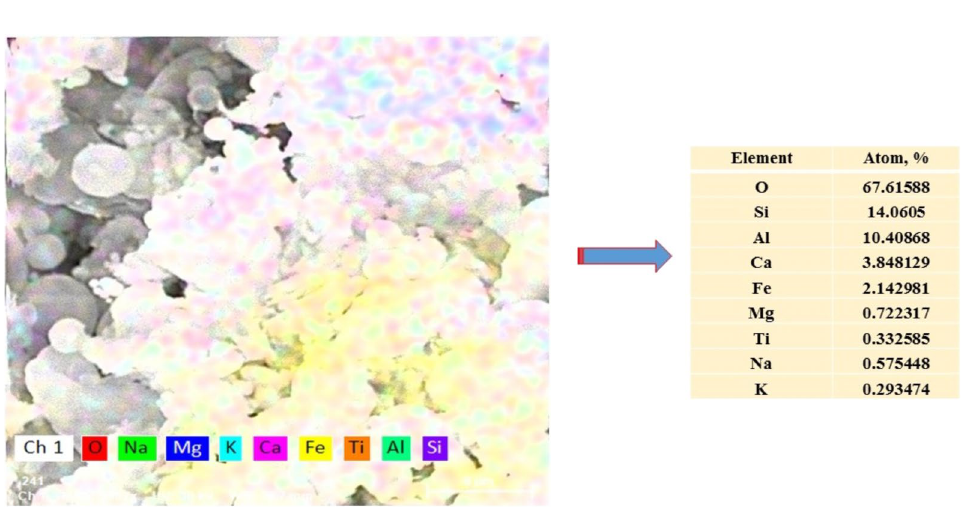
Figure 3. EDX analysis of fly